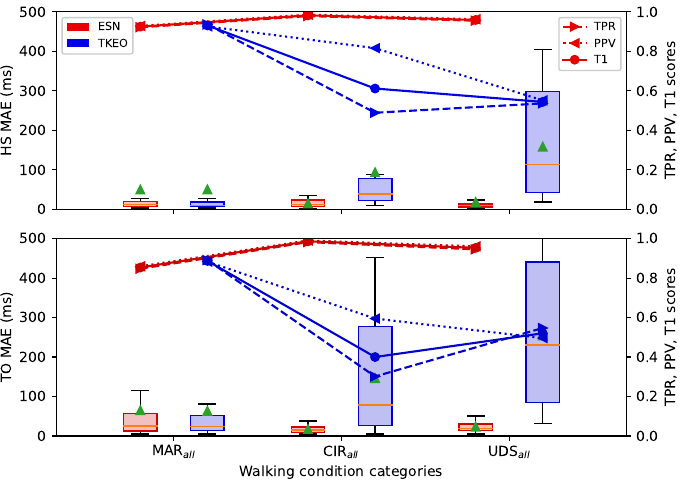
Figure 13. Comparison of MEA, FPR, PPV and T1 score on the three databases for the ESN and the TKEO